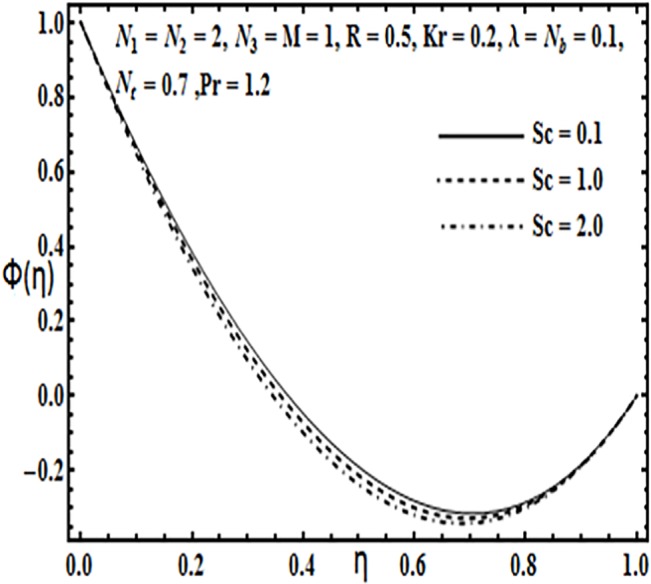
Effect of Sc on ϕ(η).